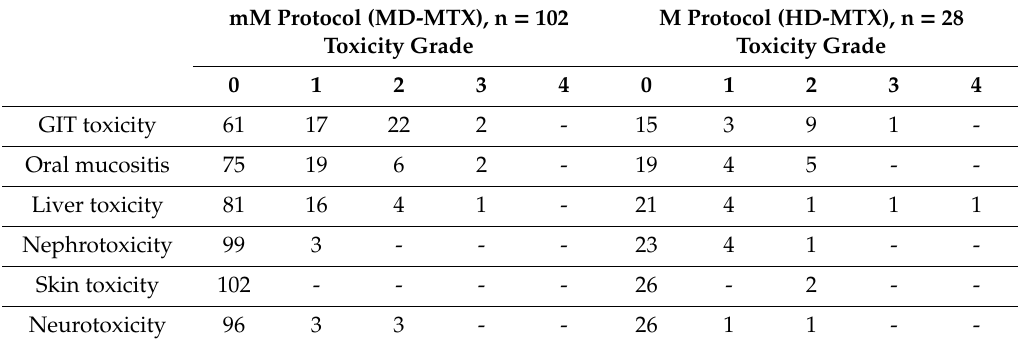
Table 2. Number of ALL patients experiencing di ff erent grade of toxicity during consolidation